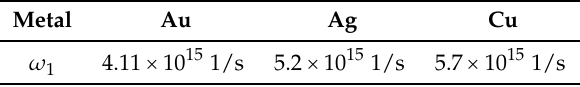
Table 1. Mie frequency ω 1 to Formula (18).